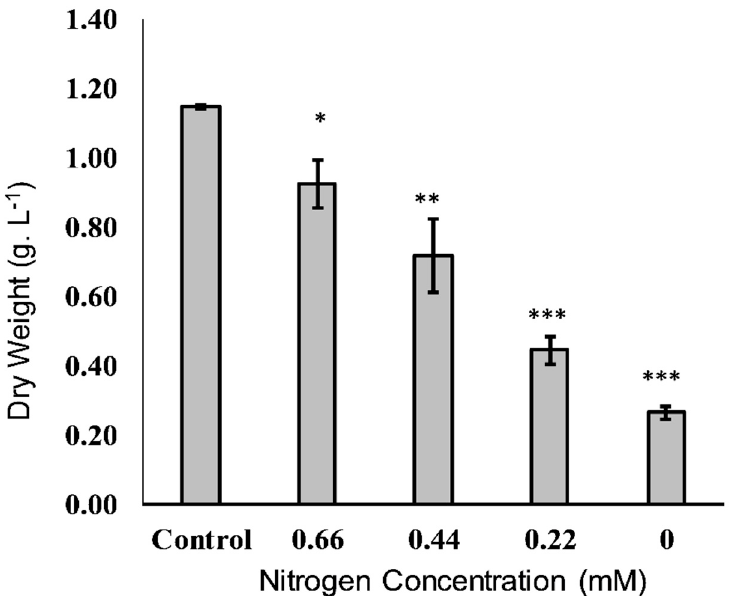
Figure 1. The cellular dry weight of Tisochrysis lutea grown mixotrophically at different concentrations of NaNO 3 . * p < 0.05, ** p < 0.01, *** p < 0.001 with respect to the control (0.88 mM).